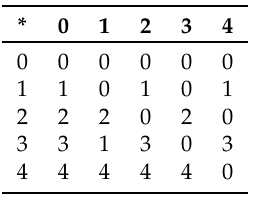
Table 3. Cayley table for the binary operation